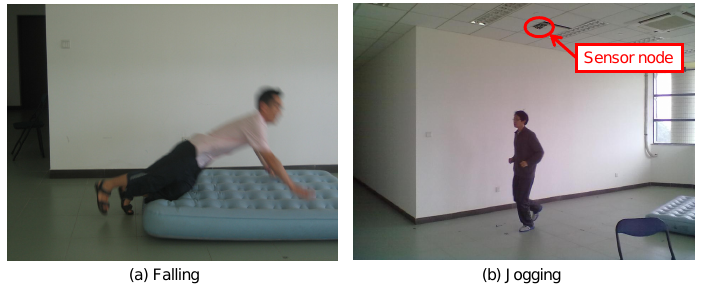
Figure 5. Different volunteers emulated different activities with their own speed and strategy: ( a ) Falling; ( b )